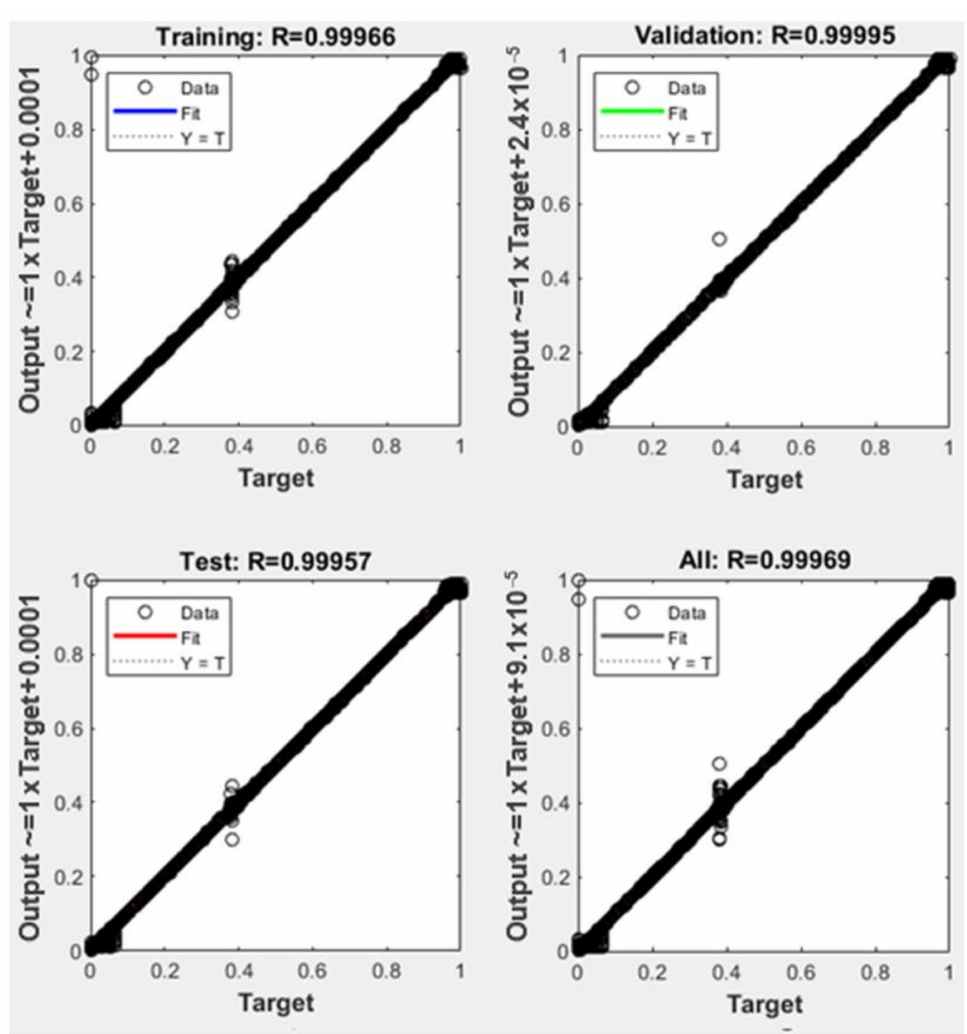
Figure 7. Neural network training results obtained for coarse estimation involving network 1